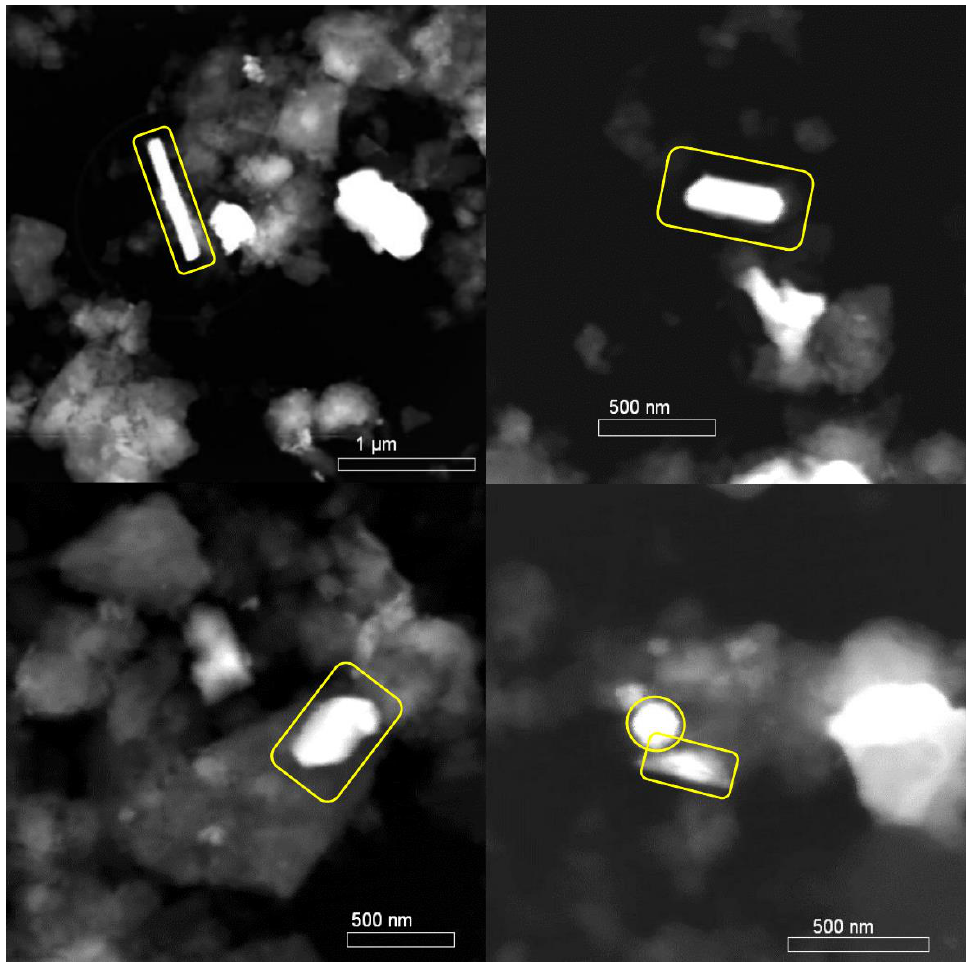
Figure 5. Images obtained using HR-TEM in HAADF scanning mode of soil particles extracted from S2. Ti-containing particles are framed in yellow. Separations 2018 , 5 , x FOR PEER REVIEW 10 of 15